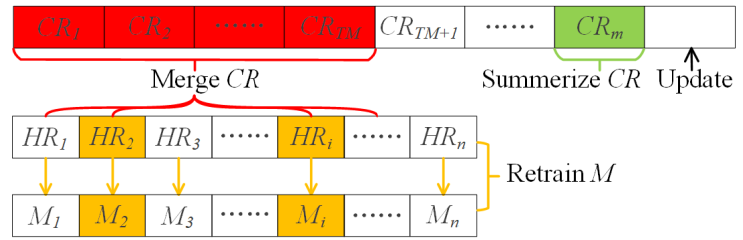
Figure 2. Update processing in